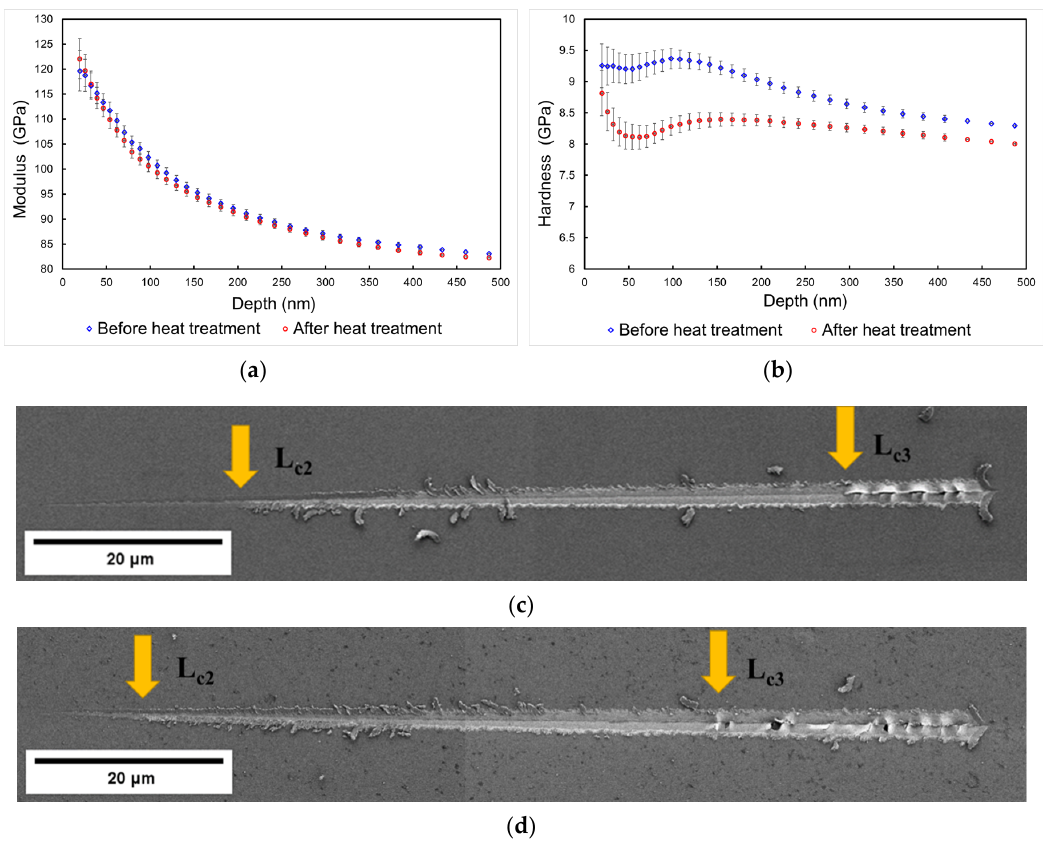
Figure 7. Nanomechanical testing on the film before and after the heat treatment. ( a ) Nanoindentation modulus profile, ( b ) nano-hardness profile, ( c ) SEM micrograph of a nanoscratch test BEFORE the heat treatment, ( d ) SEM micrograph of a nanoscratch test AFTER the heat treatment. Table 1. Result summary on nanoindentation and nanoscratch experiments.